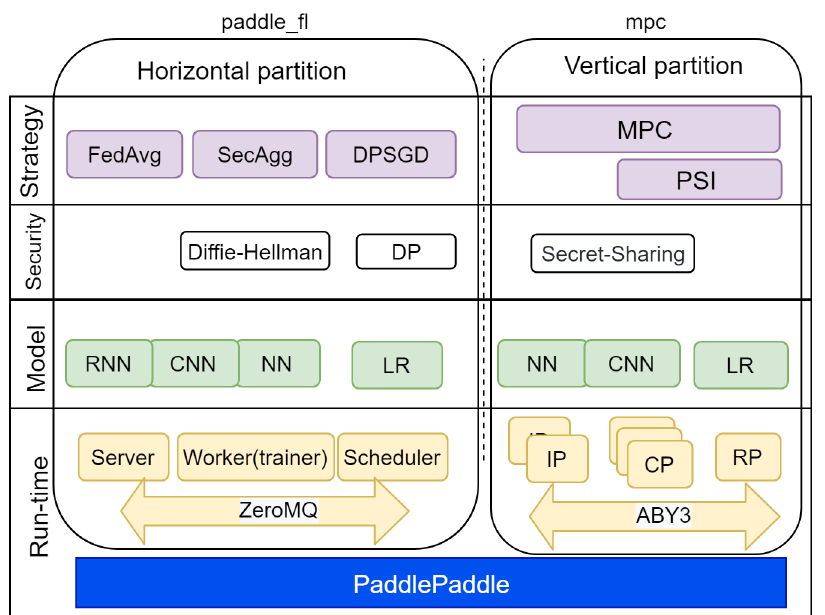
Figure 6. Architecture of Paddle Federated Learning (PFL).